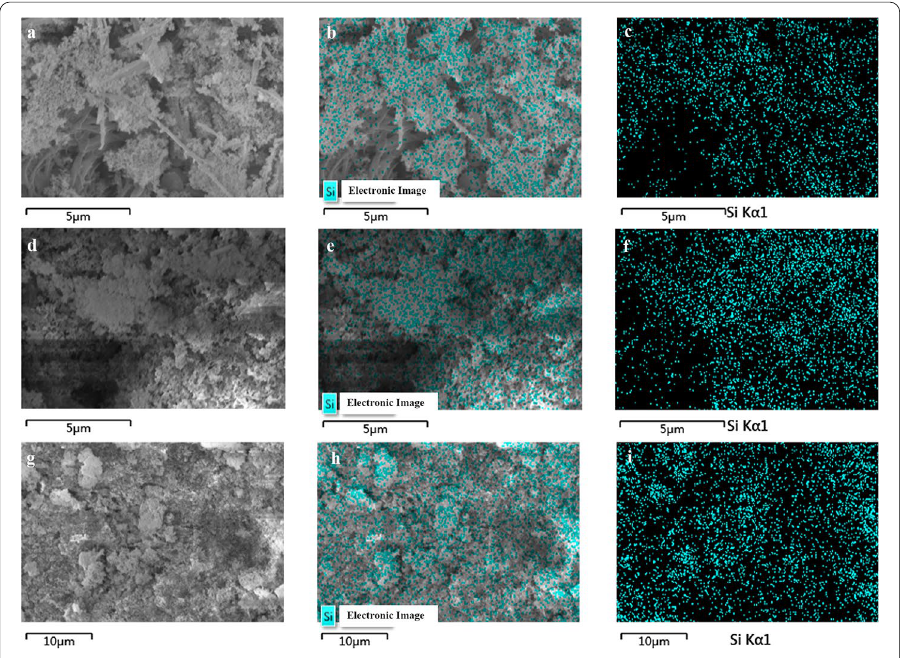
Fig. 6 SEM images of L-SiO 2 -1/PM ( a ), L-SiO 2 -2/PM ( d ) and L-SiO 2 -3/PM ( g ). EDS mapping images of L-SiO 2 -1/ PM ( b , c ); L-SiO